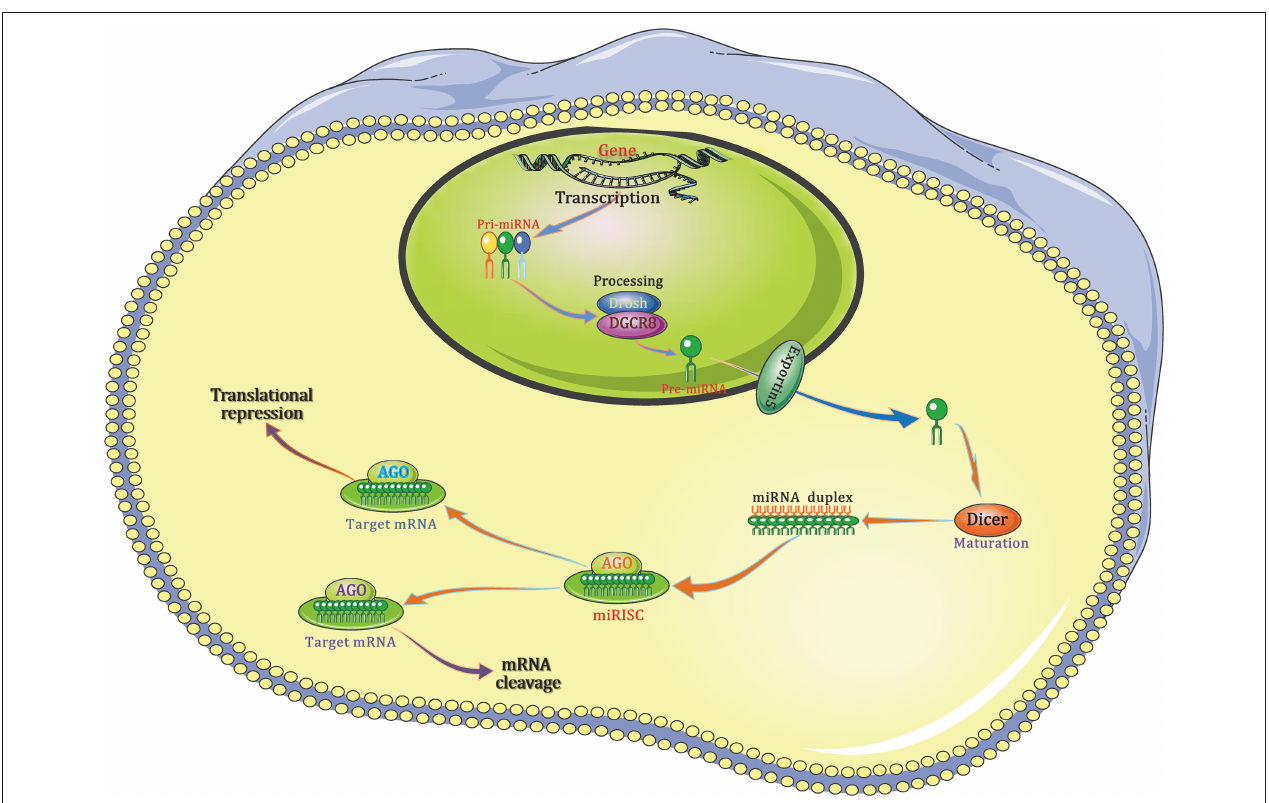
FIGURE 1 | The canonical pathway of miRNA biogenesis. Pri-miRNA is then cleaved by the Drosha/DGCR8 complex to form pre-miRNA, which is exported from the nucleus to the cytoplasm by exportin 5. Once in the cytoplasm, the pre-miRNA is cut into a small, immature dsRNA duplex that contains both the mature miRNA strand and complementary strand by another RNase-III–type endonuclease, Dicer. One strand of the mature miRNA forms a complex with Dicer and the Argonaute protein, also called miRNA-containing RISC, and the miRNA binds to the 3 ′ -UTR of its target mRNA, resulting in target mRNA degradation or translational repression. AGO, Argonaute; DGCR8, DiGeorge syndrome critical region 8; miRISC, miRNA-containing RNA-induced silencing complex; 3 ′ -UTR, 3 ′ -Untranslated